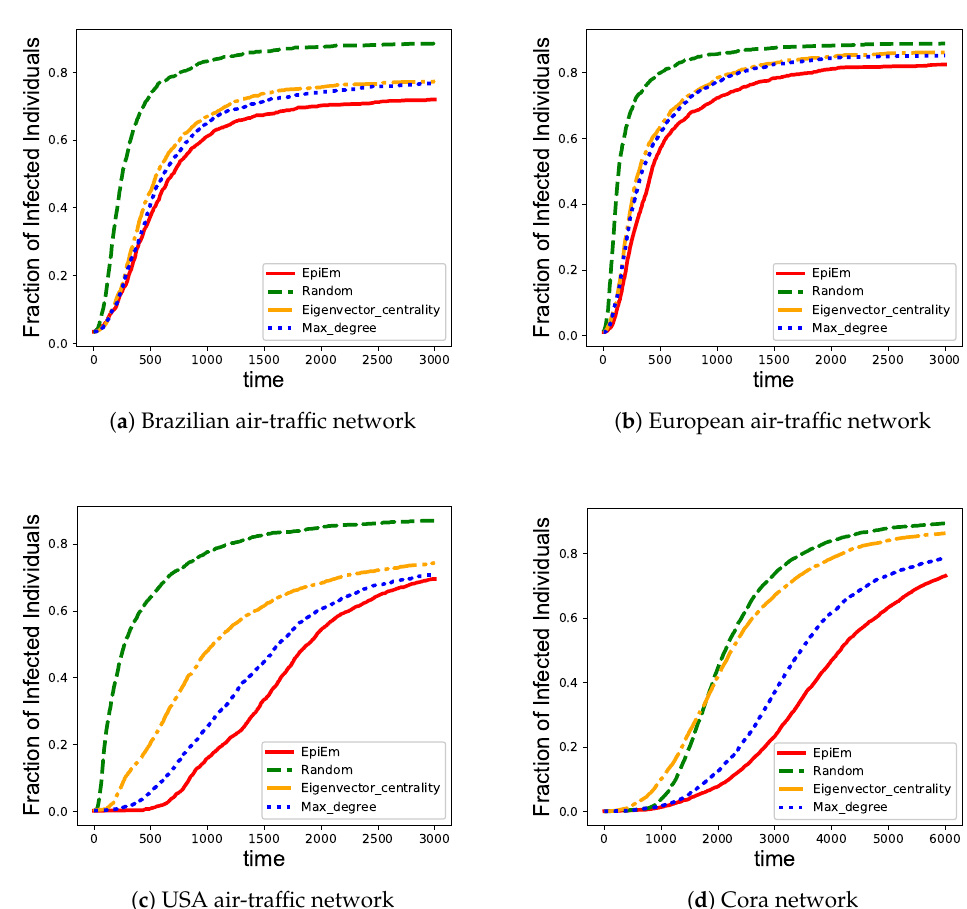
Figure 3. Performance comparison among different immunization strategies on four benchmark networks. ( a ) Brazilian air-traffic network; ( b ) European air-traffic network; ( c ) USA air-traffic network; and ( d ) Cora network. The x axis represents the infection time of the nodes. The y axis represents the fraction of infected nodes in the